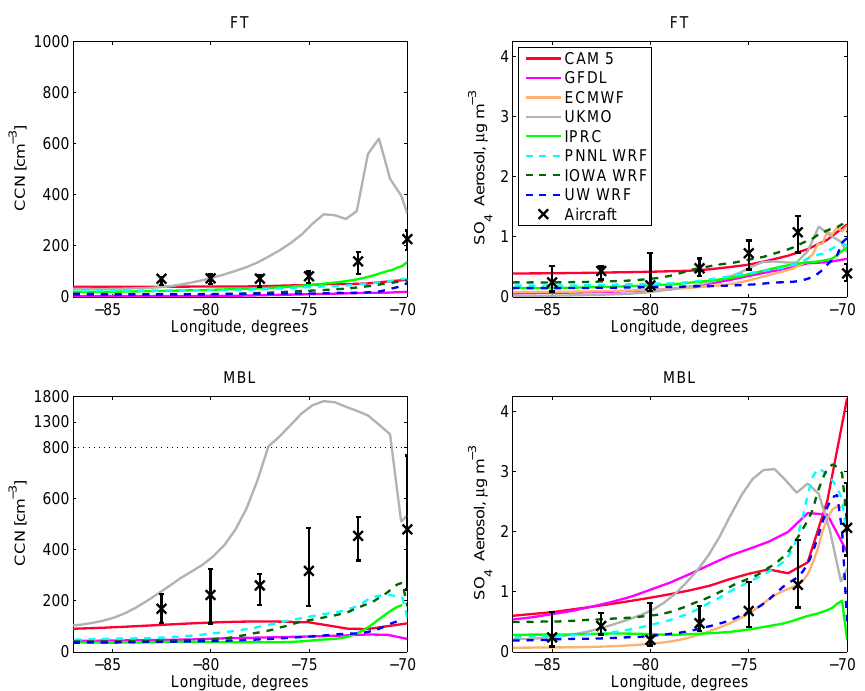
Figure 7. CCN concentrations at 0.1% supersaturation (in cm − 3 ) along 20 ◦ S are shown in the left-hand side panels. FT mean (top left) and concentration at 150m (lower left). C-130 nephelometer means are plotted with “x” symbols. Sulfate aerosol (SO 4 ) dry mass concentrations (in µgm − 3 ) of diameter range 0.05–0.5µm measured with AMS (C-130 and BAe-146) are compared with model dry mass concentration along 20 ◦ S (see Allen et al., 2011) in the right-hand side panels for the FT (top right) and MBL mean (bottom right). The lower-left panel is linearly rescaled at the top of the plot. The lower-right panel is modified from a figure in Mechoso et al. (2014) to add aircraft sampling variability. Note that ECMWF CCN concentrations are unavailable.